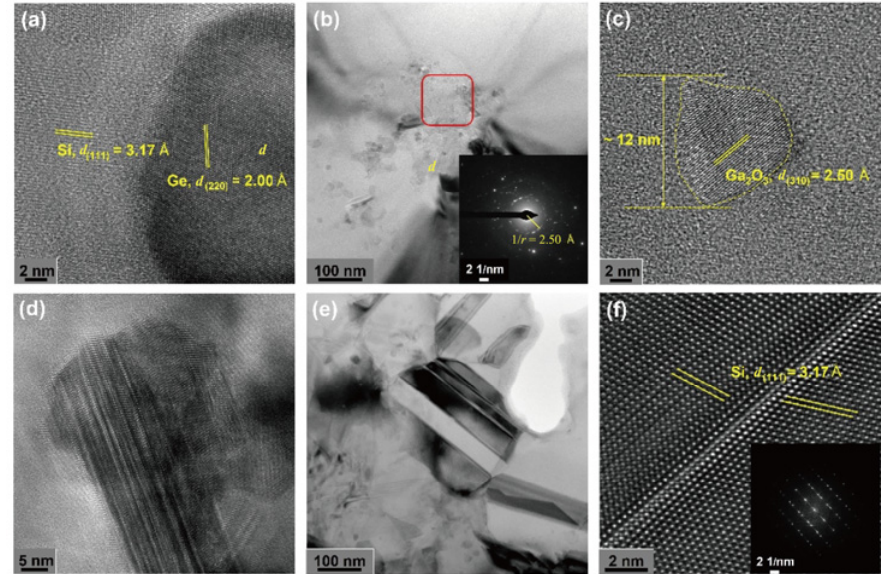
Fig. 8 (a) HRTEM image of the boundary region for precipitated microlite with corresponding spacings and orientations marked. (b) BF-TEM image for mixed-crystal region (the inset (rounded square area) is the SAED pattern). (c) HRTEM image of fine grain with corresponding spacing and orientation marked. (d) HRTEM image of serried stack faults. (e) BF-TEM image of faults in grain and (f) HRTEM image for TB (the inset is the SAED